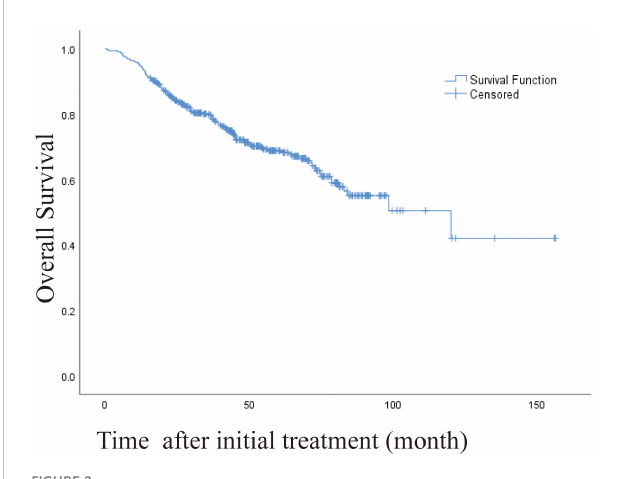
FIGURE 2 Kaplan-Meier curve of overall survival (OS) in patients with primary liver cancer who underwent radiofrequency ablation (median OS, 120